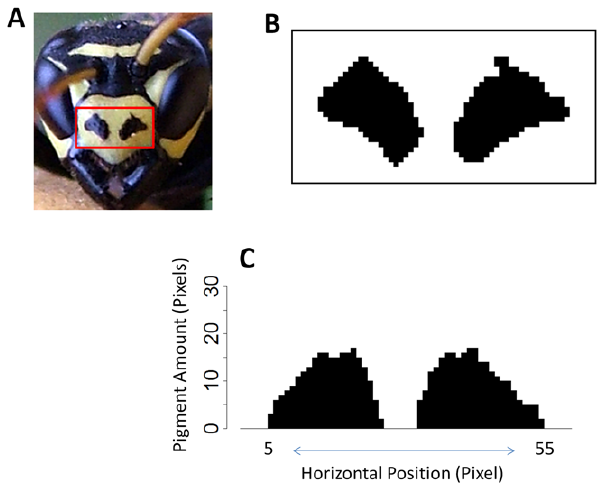
Figure 1. Illustration of the method used for analyzing facial pattern brokenness. A) P. dominulus with a red box around the facial area that is analyzed for brokenness, B) 30 6 60 pixel bitmap of the facial pattern variation, C) The number of pixels of black pigment within each vertical column along the horizontal length of the clypeus is counted and the standard deviation from column 5 to 55 is